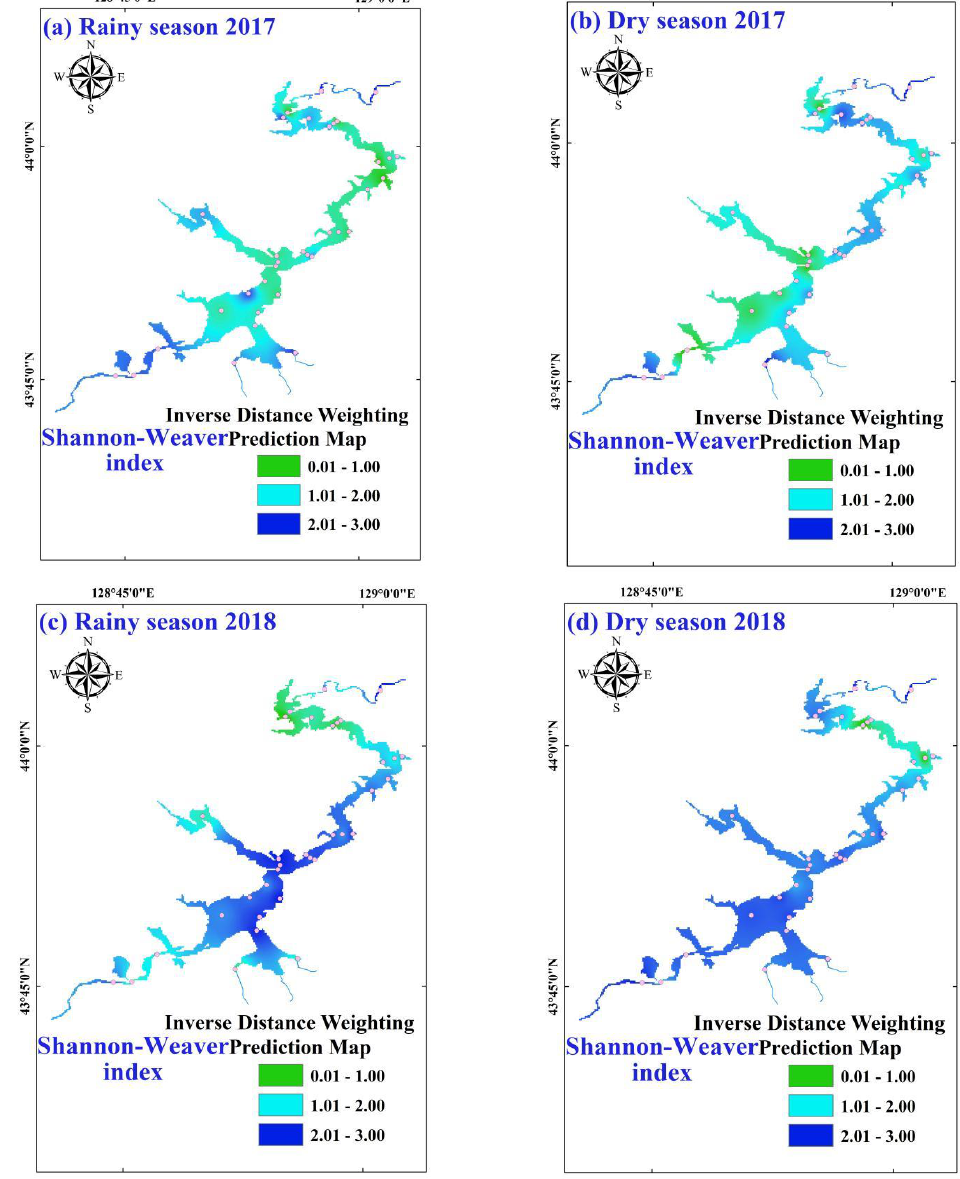
Figure 4. The spatial distribution of Shannon‒Wiener Index in study period. ( a ) Rainy season (August 2017); ( b ) dry season (October 2017); ( c ) rainy season (August 2018); ( d ) dry season (October 2018). The interpolation map was constructed by ArcGIS software using the Inverse Distance Weighting method.